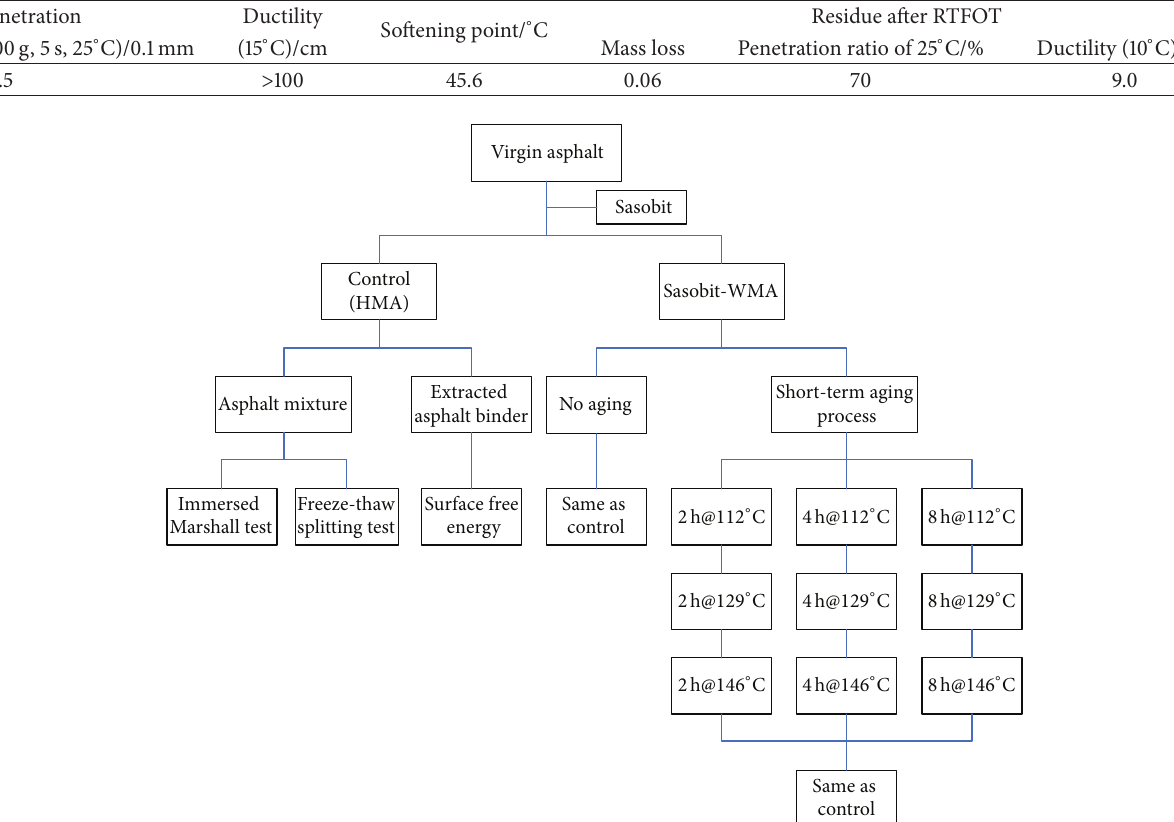
Figure 2: Flowchart of experimental design